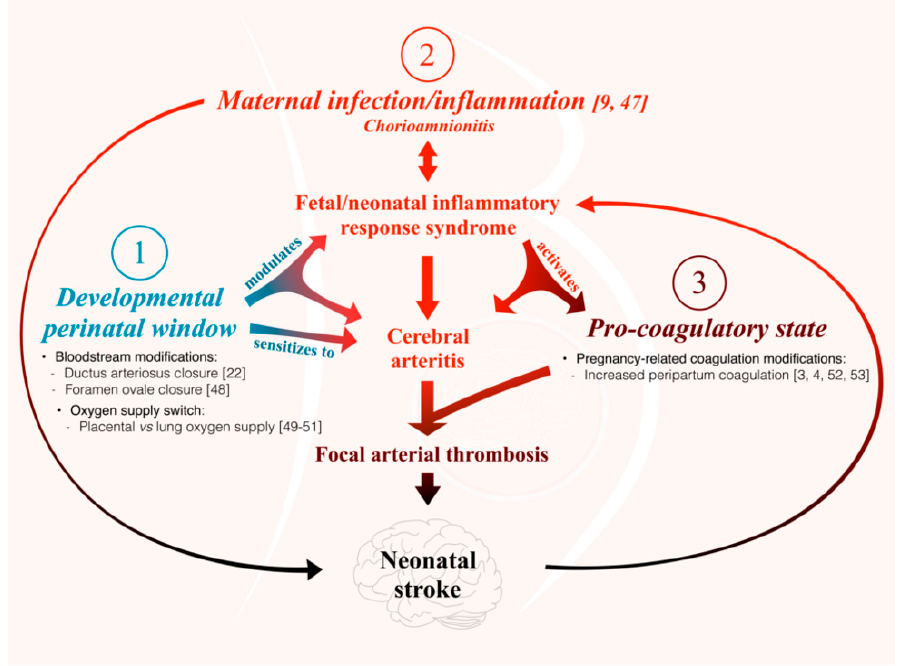
Figure 7. Physiopathological paradigm of simultaneously combined perinatal triple risk factors leading to